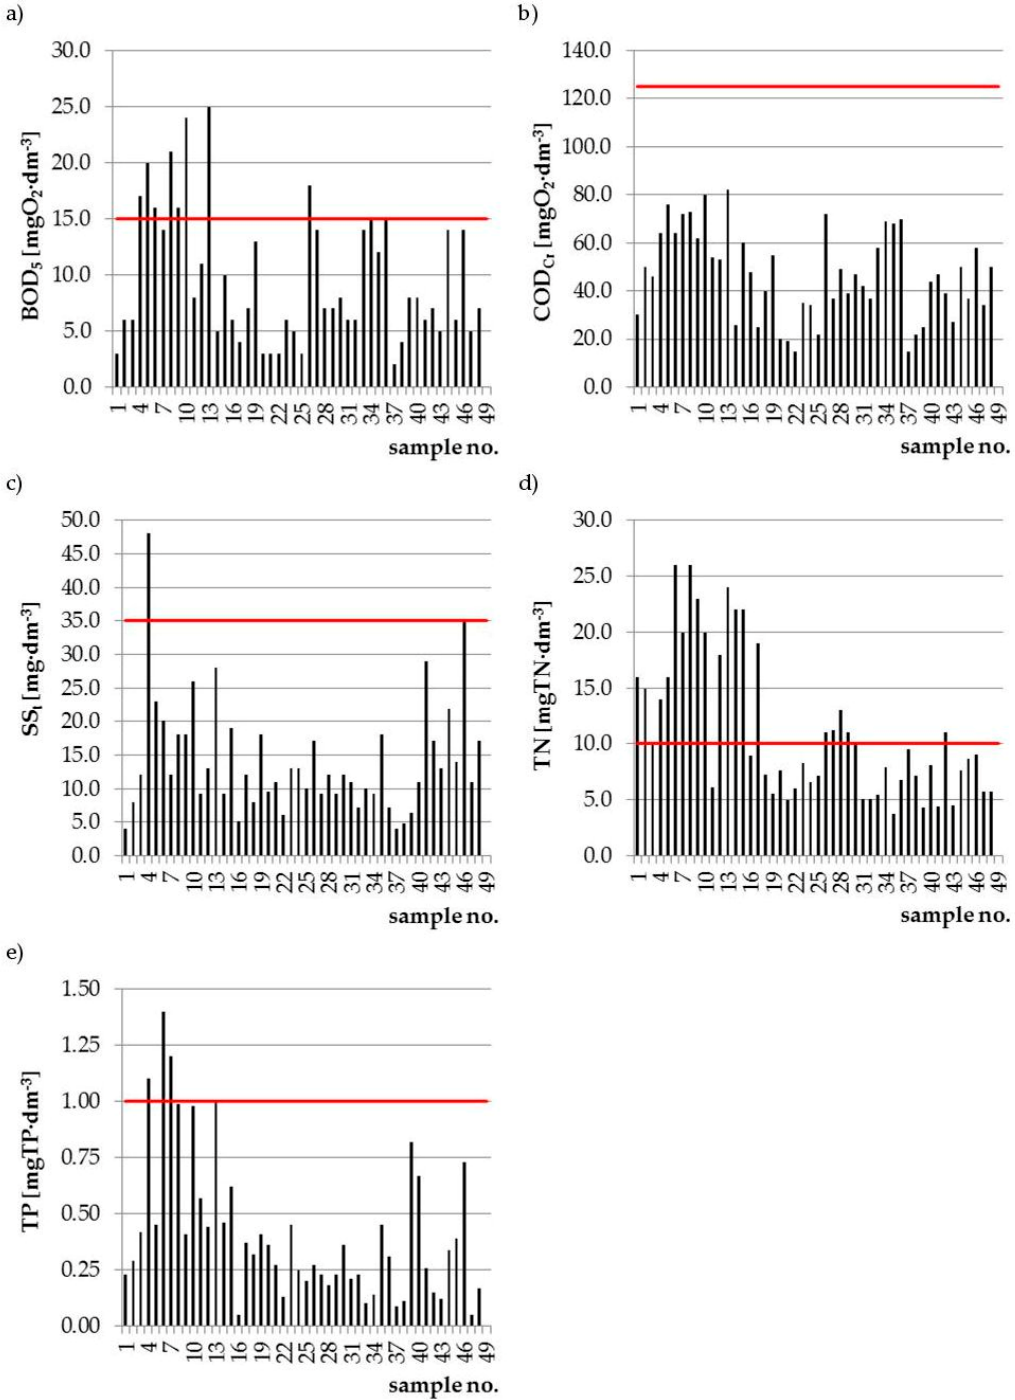
Figure 2. The values of pollutants indicators in treated sewage with its permissible levels: ( a ) Biochemical Oxygen Demand (BOD 5 ), ( b ) Chemical Oxygen Demand (COD Cr ), ( c ) Total Suspended Solids (SS t ), ( d ) Total Nitrogen (TN), and ( e ) Total Phosphorus (TP). Table 1. The values of the descriptive statistics for pollutants indicators observational series. Descriptive Statistics Pollutants Indicators